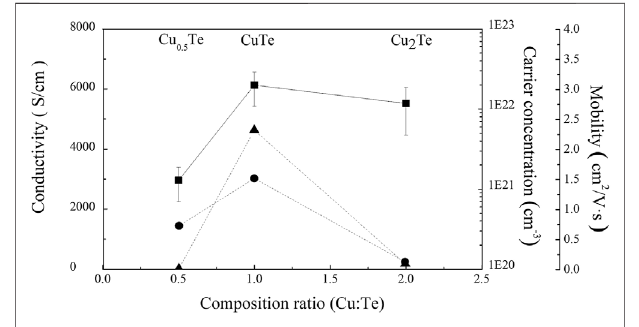
FIGURE 5 | Electrical properties of thin fi lms deposited by electrodeposition as functions of the Cu/Te compositional ratio [ ▲ (cid:2) Conductivity (S/cm), ■ : Carrier concentration (cm − 3 ), C (cid:2) mobility (cm 2 /V s)].